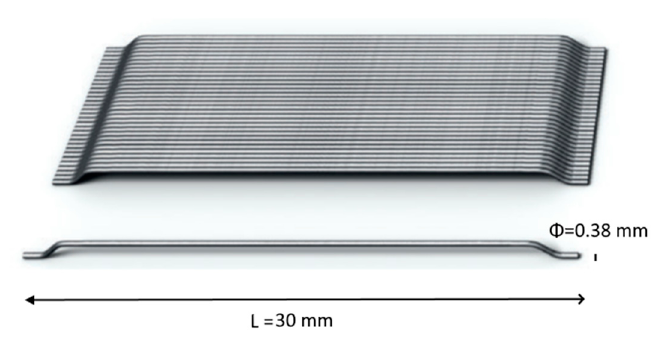
Figure 2. Overview of SF.